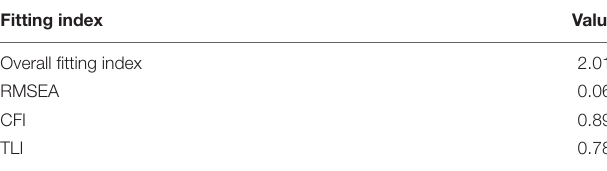
TABLE 5 | Statistics data of all variables and related